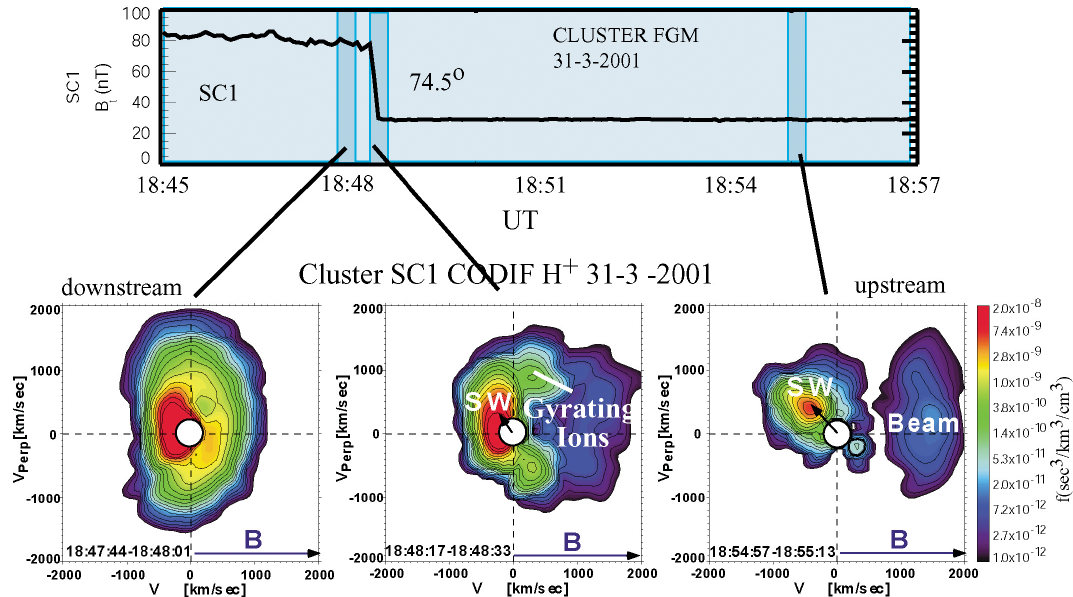
Fig. 5. Magnetic field (top panel) and ion distribution (lower panel) in velocity space downstream, in the ramp, and upstream of the bow